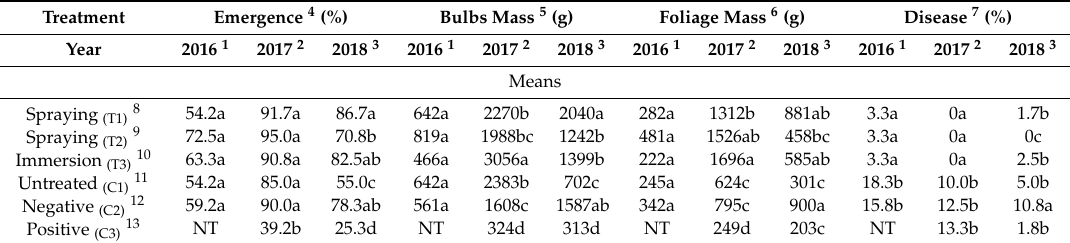
Table 4. Mean values of onions treatments assessed in field trials 2016–2018.